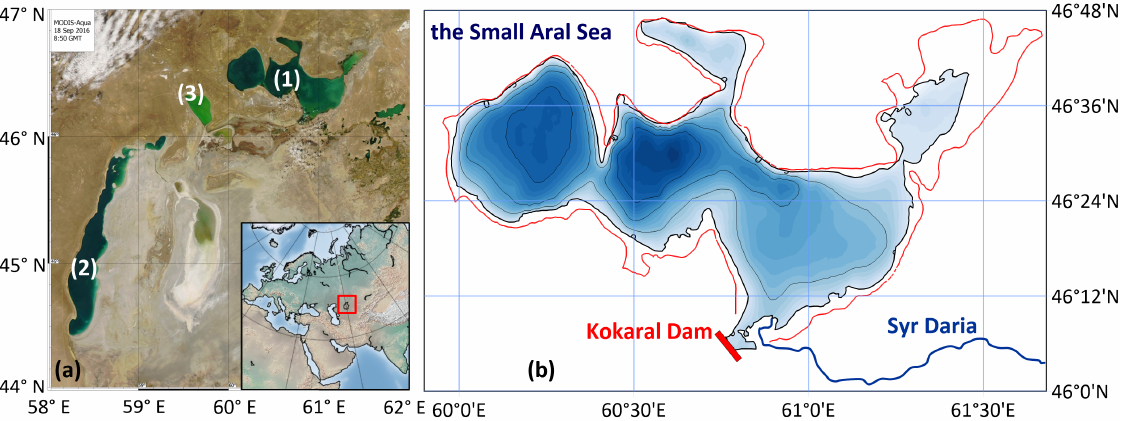
Figure 1. Residual basins of the Aral Sea seen from satellite ( a ): the Small Aral Sea (1), the Large Aral Sea (2) and Lake Tshchebas (3). The Small Aral Sea ( b ) within its present boundaries determined by the Kokaral Dam (42.5 m.a.s.l.) and its possible boundaries in case of lake surface increasing (48.5 m.a.s.l., red